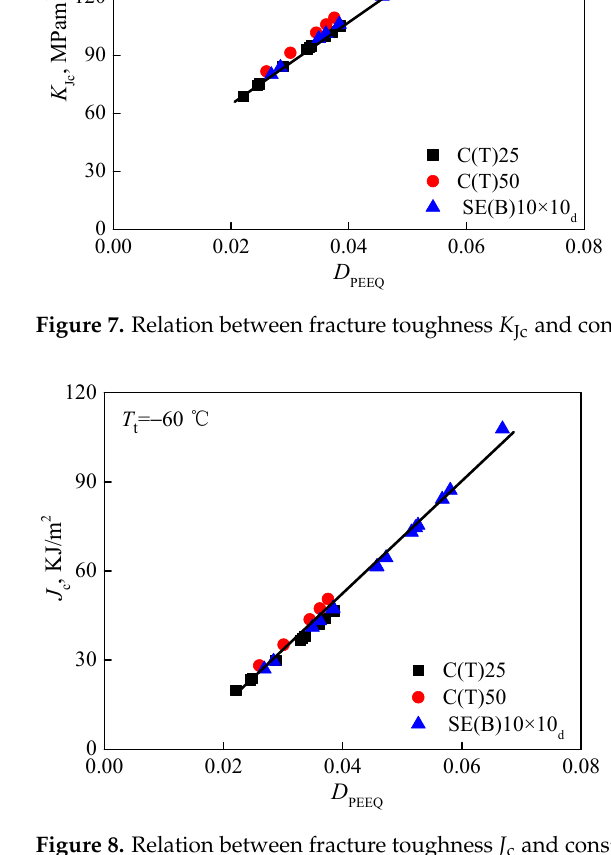
Figure 8. Relation between fracture toughness J c and constraint parameter D PEEQ .